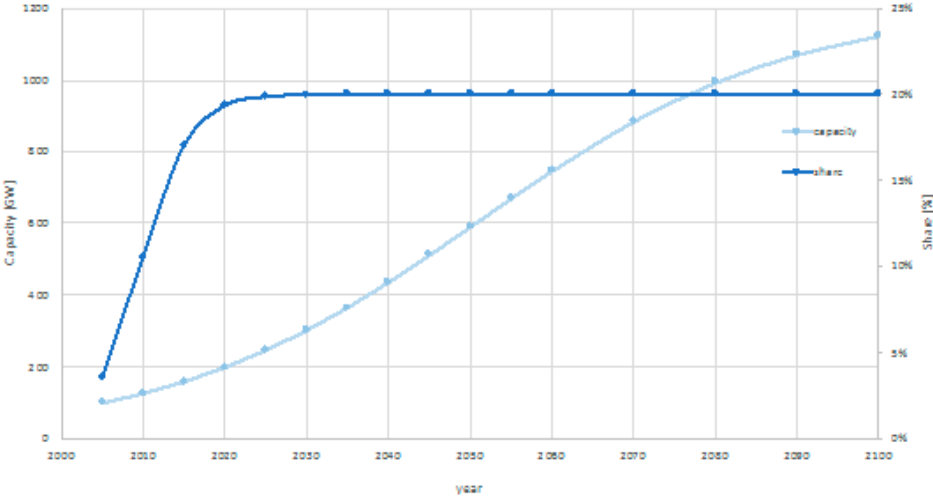
Table 8. Parameters calculated for the S-shaped wind technology curves (Figures 7 and 8).